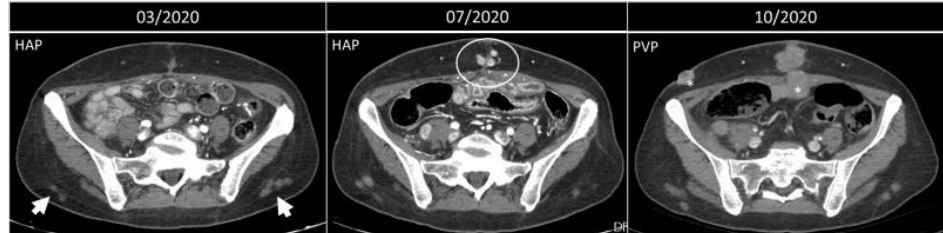
Figure 12. Progression of metastatic disease vs. injection granulomas. Axial, contrast-enhanced arte- rial and portal-phase CT scans of a 50-year-old woman with NEC of the small bowel. Three months after the surgery, some lesions on the subcutaneous fat of the lower back are noted (arrowheads). Four months later, these nodules are the same size, while along the surgical scar, new enhancing nodules appear (circle). In October 2020, these latter lesions become confluent and bigger, and other lesions appear (*), all compatible with metastatic nodules, while the nodules on the pos- terior abdominal wall are simple granulomas.